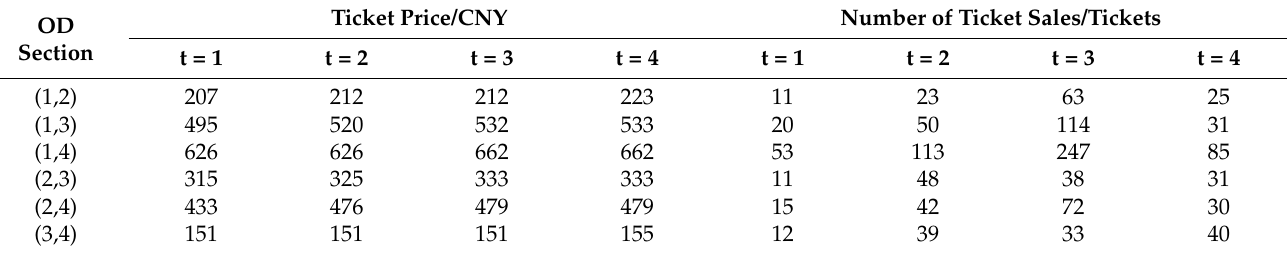
Table 8. Model results.